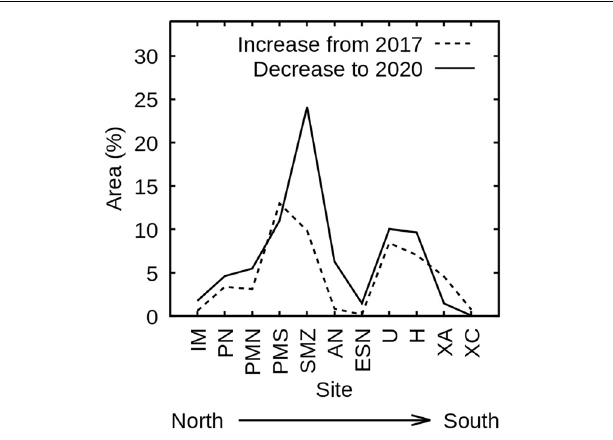
FIGURE 14 | Effect of Sargassum on LAI estimates at the sites of interest ordered north to south. Dashed line is net area with increase in estimated LAI greater than 0.5 ( p < 0.01) from 2017 to 2018 and 2018 to 2019 summed. Solid line is net area decrease greater than 0.5 ( p < 0.01) 2019 to